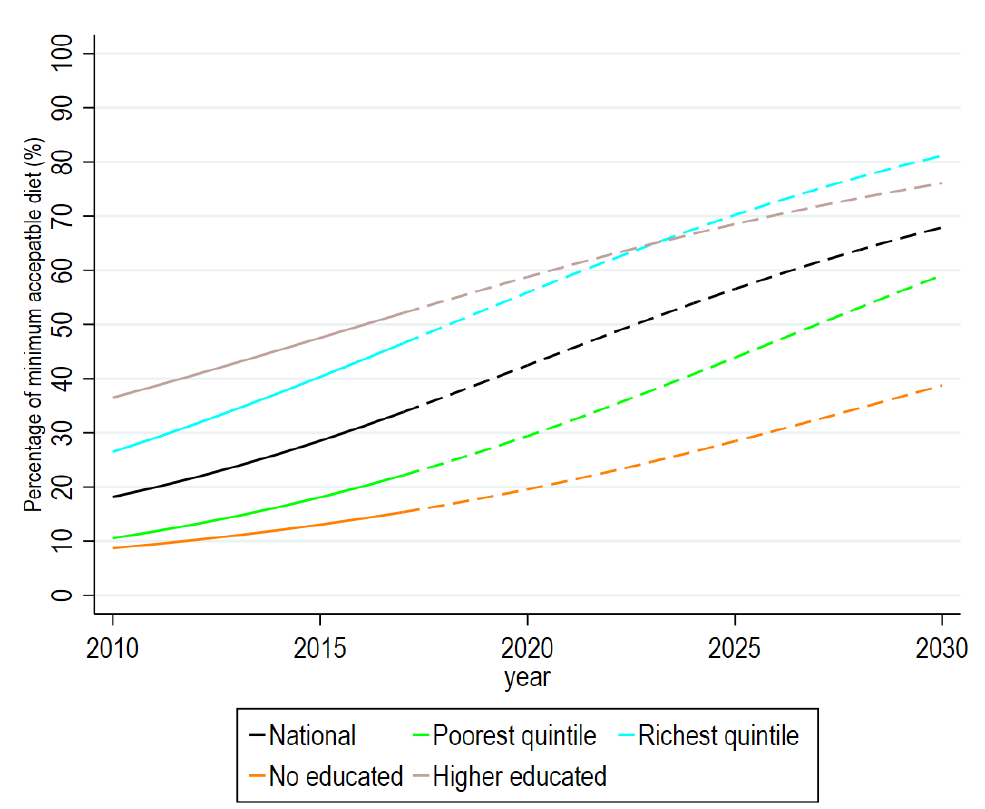
Figure 2. Adjusted prevalence of minimum diet diversity, minimum diet frequency and minimally accepted diet among Bangladeshi children aged 6–23 months. Note: Models were adjusted by age and sex of child, and age of mother. Exact prevalence along with 95% confidence intervals are presented in Table S7.